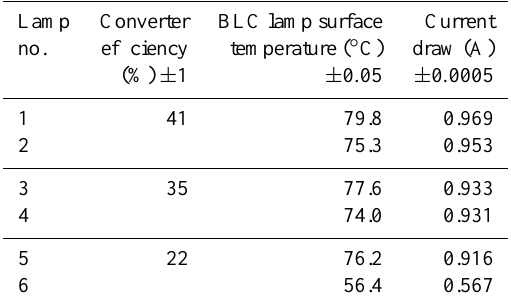
Figure 6. Absorption cross section (red) and quantum yield (dashed black) of NO 2 , presented with the spectral output of UG5 optical filtering (purple) and an average of the six BLC lamps used in this study output (dark blue). Interfering species are shown – NO 3 rad- icals (green), HONO (light blue), and BrONO 2 (lilac) – which are overlapped significantly by the UG5 optics – completely in the case of HONO, whilst much less overlap is exhibited by the UV LEDs of the BLC. Also shown is PAN (gold), which is clearly not overlapped by either UG5 or BLC light sources. Additional non-interfering species – ClONO 2 (triangles), N 2 O 5 (squares), HO 2 NO 2 (circles), and HNO 3 (diamonds) – shown for reference. Table 3. Peak surface temperature and current drawn by BLC lamps in a bench test at 20.0 ◦ C showing converter efficiency, current, and surface